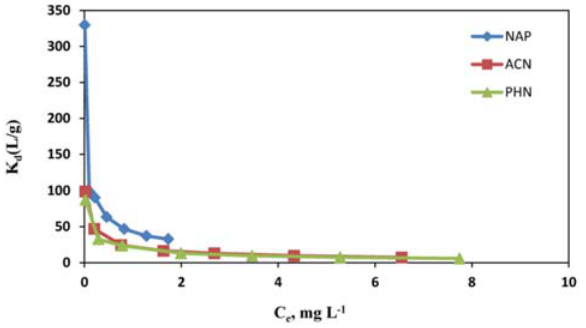
Fig. 9. Adsorption coefficients of NAP, ACN, and PHN onto GO-9- AA in different